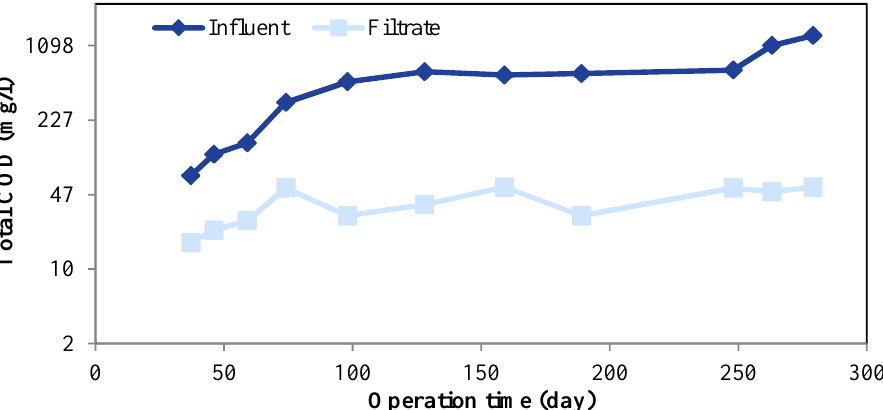
Figure 3. Variations of total chemical oxygen demand (COD) during reactor operation